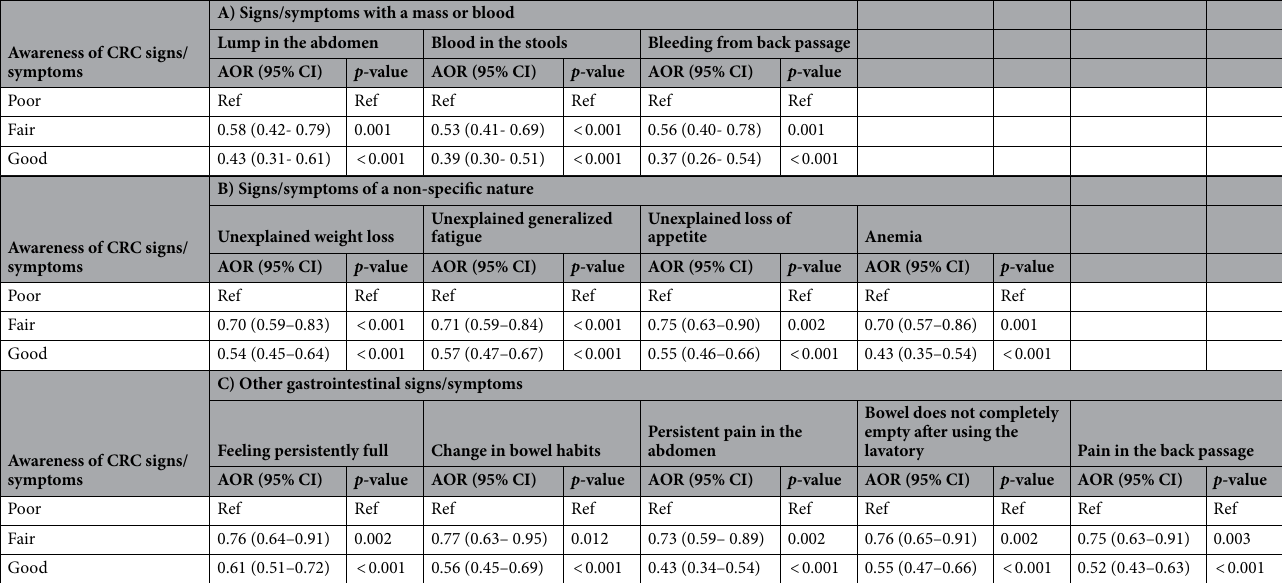
Table 3. Multivariable logistic regression analyzing the association between no seeking of medical advice and awareness of colorectal cancer symptoms. AOR = adjusted odds ratio, CI = confidence interval, CRC = colorectal cancer. All analyses were adjusted for age-group, gender, educational level, occupation, monthly income, having a chronic disease, following a vegetarian diet, knowing someone with cancer, marital status, residency, and site of data collection. The outcome in all models is binary, where answers with ‘never’ were considered as ‘yes’ and all other answers were considered as ‘no’. All p-values are for the multivariable logistic regression